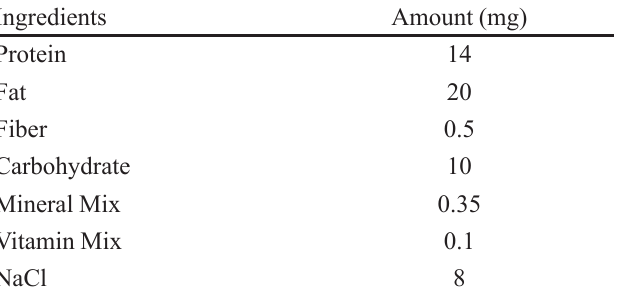
TABLE II - Diet Composition for mice for inducing Hypertension (Qianli et al., 2004)